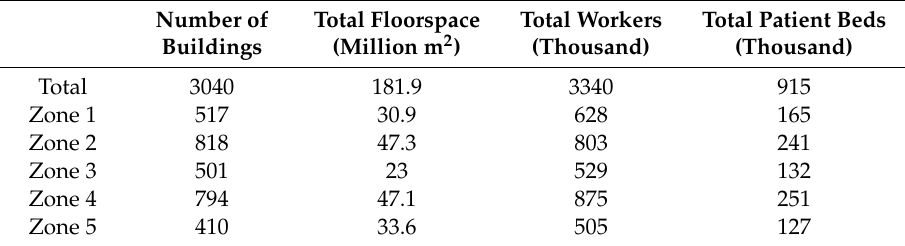
Table 4. Hospitals operational details per climate zone .